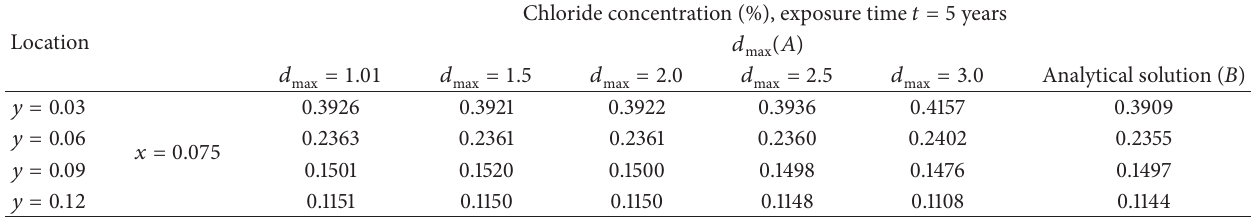
Table 5: Comparison of results with different 𝑑 max for chloride concentration at the location ( 𝑥 = 0.075 ).